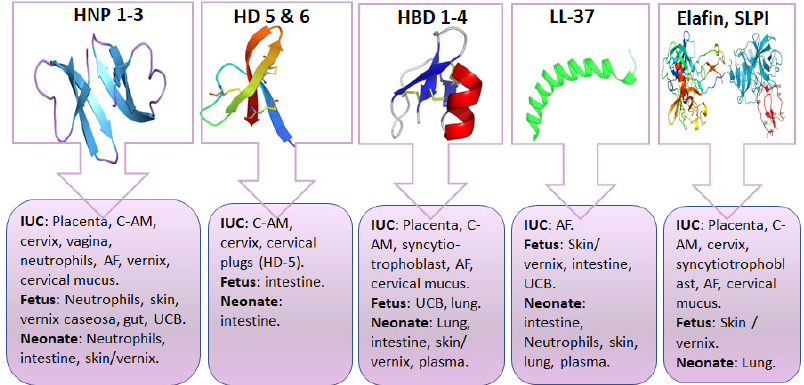
Figure 3. Sites of antimicrobial peptide detection in the maternal reproductive system during pregnancy, and in the fetus/neonate. Abbreviations: AF, amniotic fluid; C-AM, chorio-amniotic membranes; HBDs, human β defensins; HD, human defensin; HNP, human neutrophil peptide; IUC, intrauterine components; SLPI, secretory leukocyte peptidase inhibitor; UCB, umbilical cord blood.